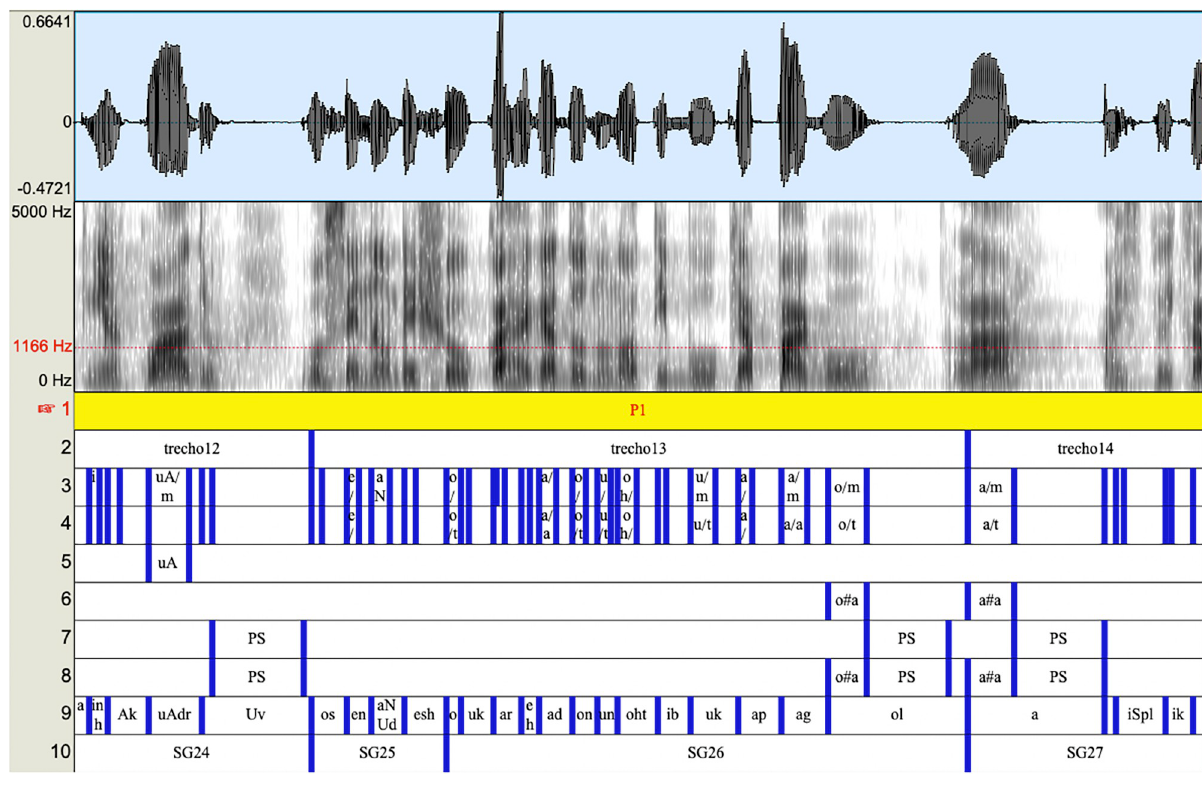
10. Smoothed z-scores peak values : smoothed z-scores peak values at the end of the stress